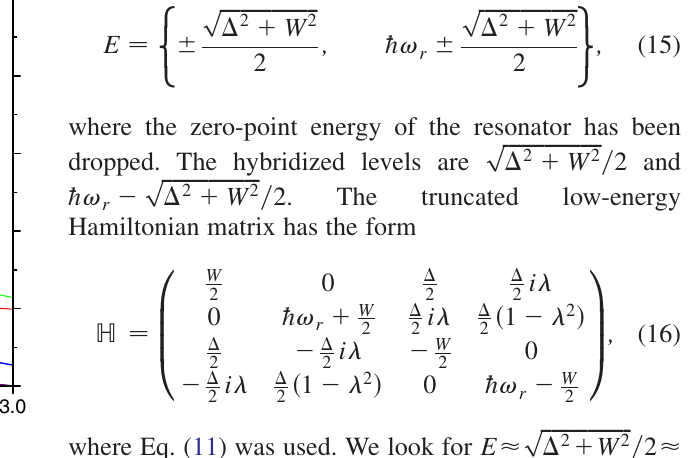
FIG. 2. Distance (cid:1) E between the ground state and the first excited state as a function of (cid:3) for different r .